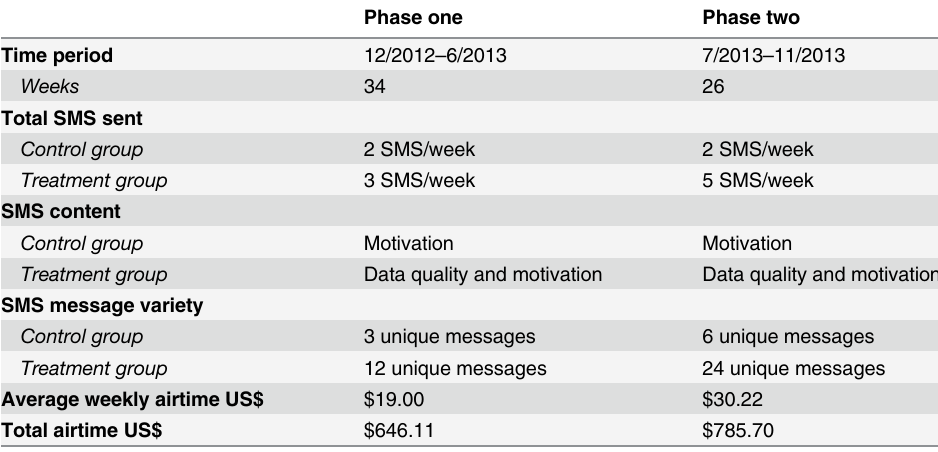
Table 1. SMS intervention two-phase